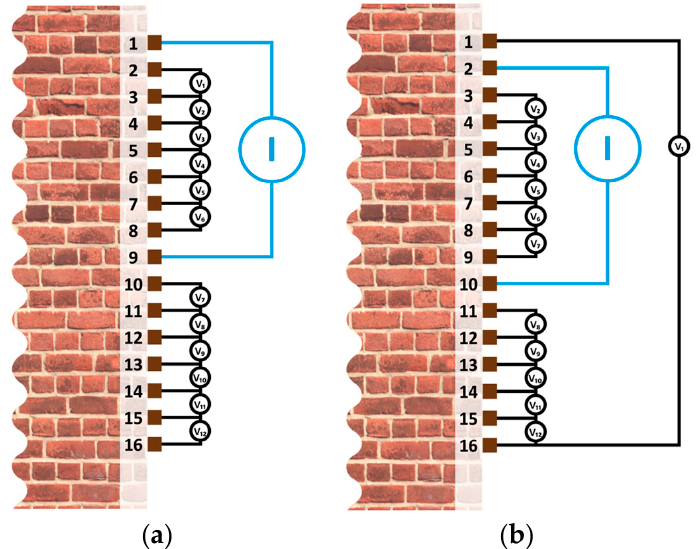
Figure 3. Performing the EIT measurement cycle with a set of 16 electrodes: ( a ) previous measurement step; ( b ) next measurement step